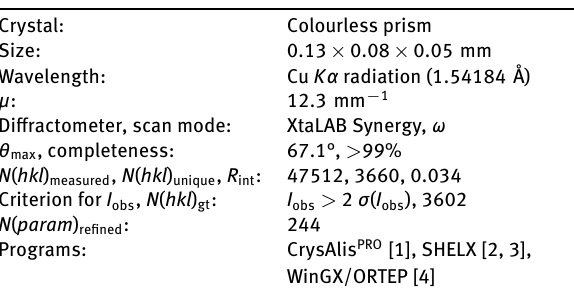
Table 1: Data collection and